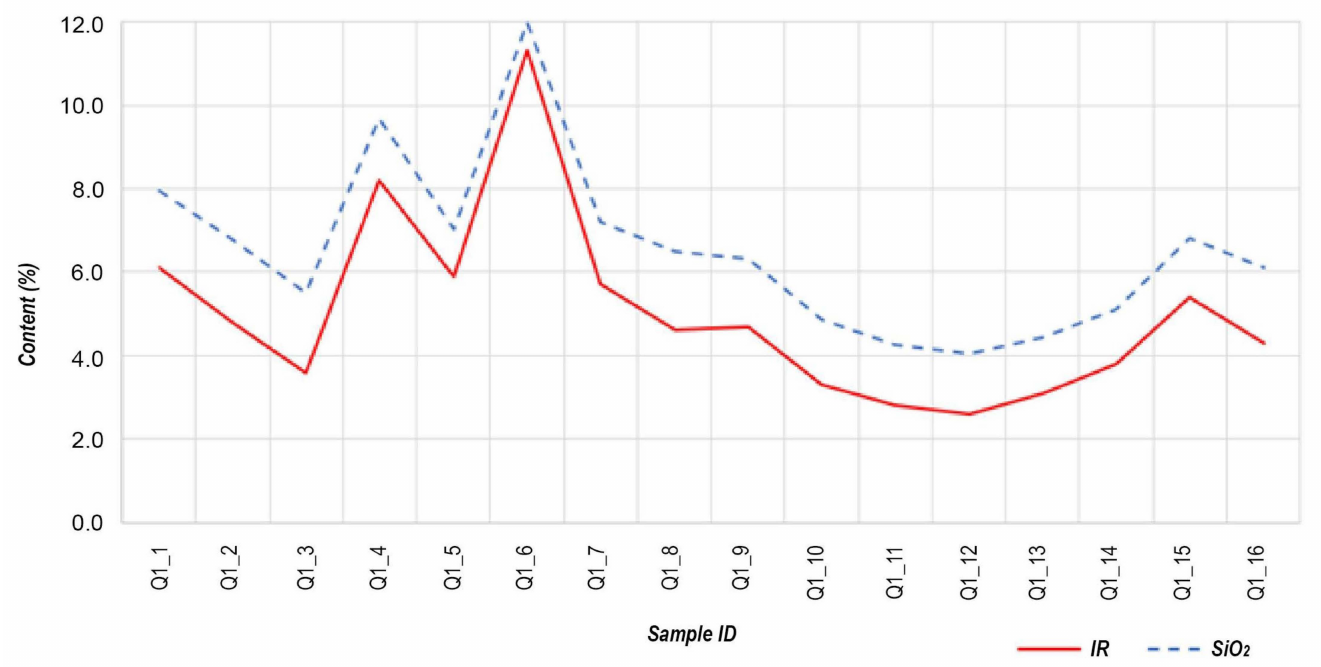
Figure 7. Variations in IR and SiO 2 .